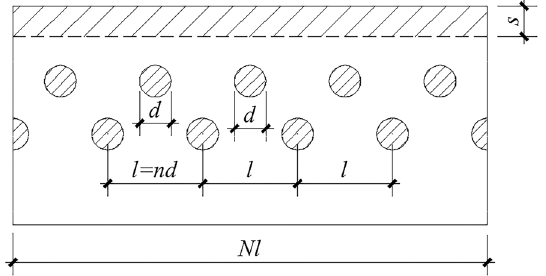
Fig. 13 Analysis diagram for diameter of excavation